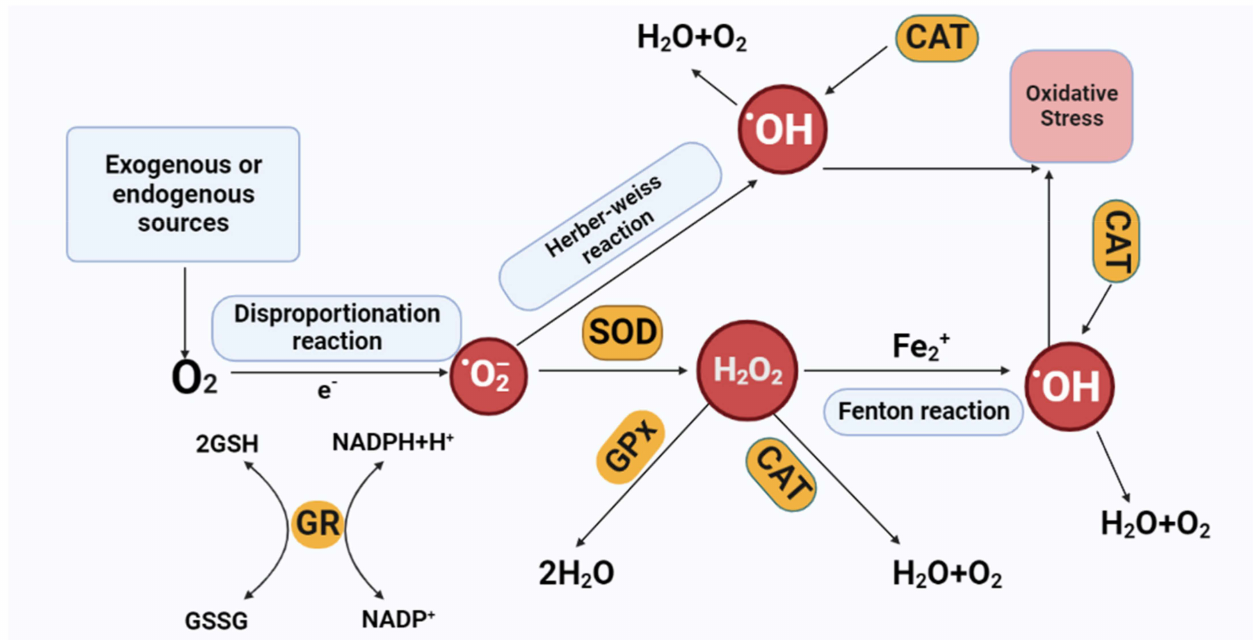
Figure 2. Scavenge and production of reactive oxygen species (ROS). Organic and inorganic con- stituents can produce, convert, and scavenge ROS. Antioxidant enzymes (SOD, CAT, GPx, and GR) intercept ROS through the chemical reactions. Oxidases convert oxygen to O 2 ·− , which is then dismutated to H 2 O 2 via SOD. H 2 O 2 can be converted to H 2 O via CAT or GPx or to hydroxyl radical ( · OH) after reaction with Fe 2+ . Abbreviations: SOD-Superoxide dismutase, CAT-catalase, GPx- glutathione Peroxidase, GR-glutathione reductase. GSH-glutathione. GSSG-glutathione